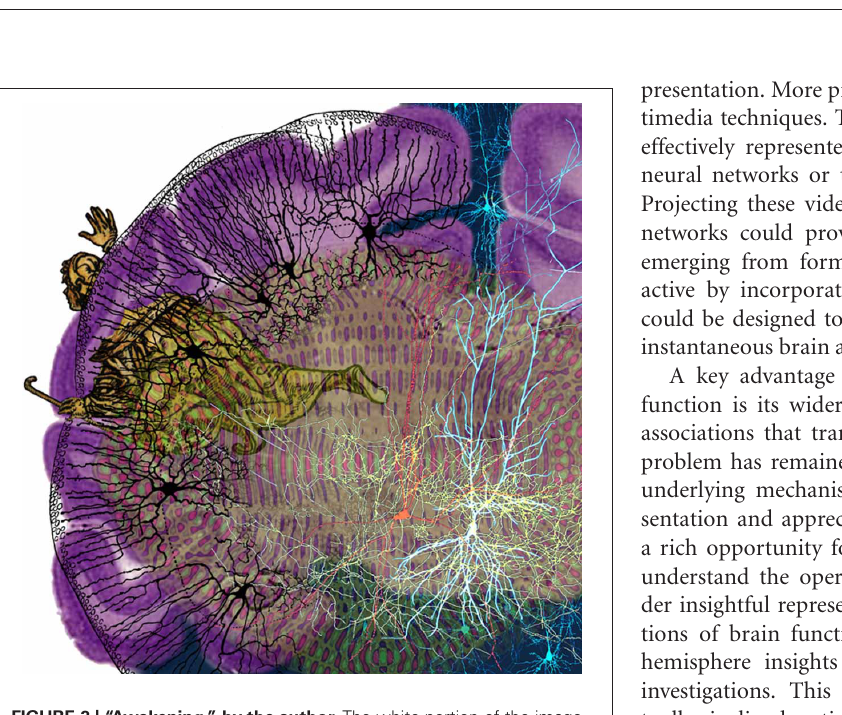
FIGURE 3 | “Awakening,” by the author. The white portion of the image is intended to be rendered as a mirror surface reflecting reality. Alternatively, the image can be rendered on clear glass, with the white portion